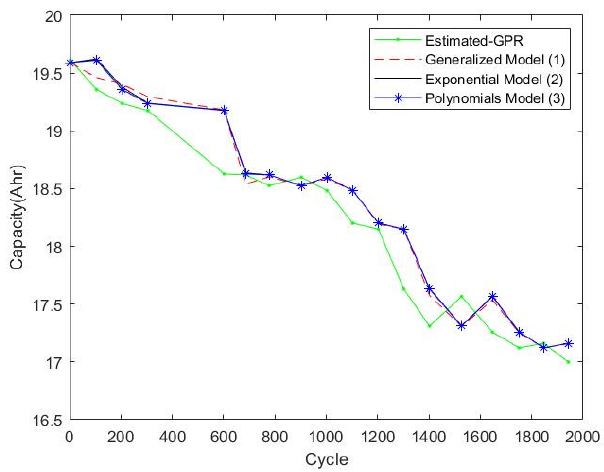
Figure 6 . Prediction by EKF based on three models. Figure 6. Prediction by EKF based on three